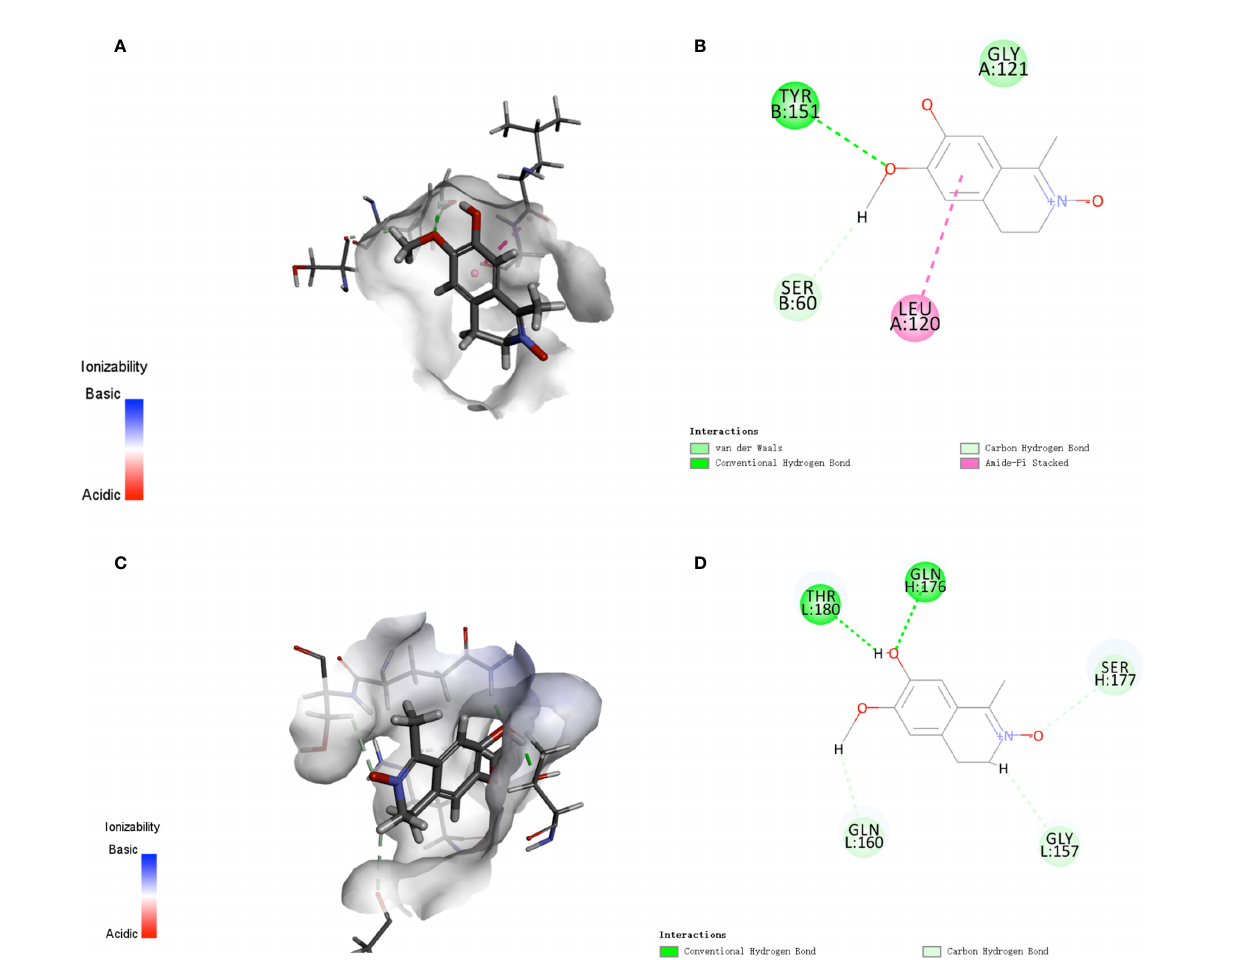
FIGURE 7 | Analysis of active targets in the structure of LA and simulation docking with TNF- a and IL-1 b (A, B) Analysis of active targets in the structure of LA and simulation docking with the TNF- a crystal structure shows that in theory LA can directly bind to TNF- a via an interaction with the LEU 120 and TYR 151 residues to elicit its inhibitory effect (24). (C, D) Analysis of the active targets in LA and simulation docking with the IL-1 b crystal structure shows that in theory LA can directly bind to IL-1 b via interactions with the THR180 and GLN176 residues to elicit its inhibitory